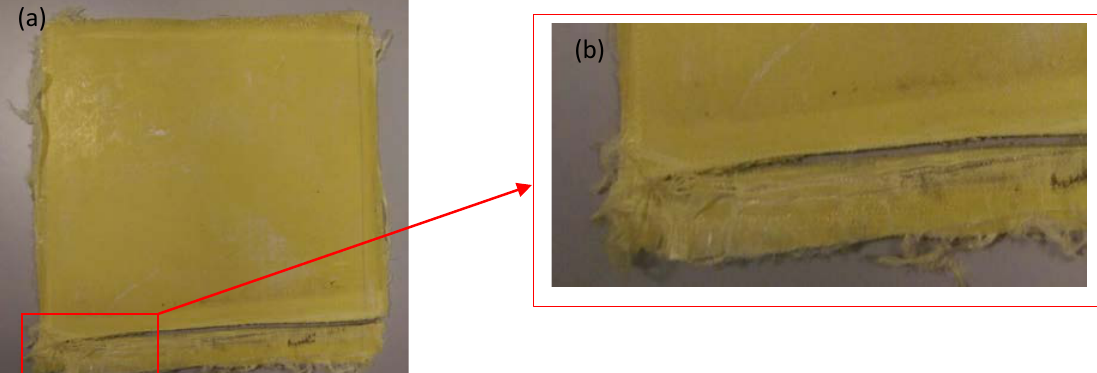
Figure 2. ( a ) Kevlar/epoxy composite plate prepared at 80 °C; ( b ) delamination of the Kevlar layers during cutting.